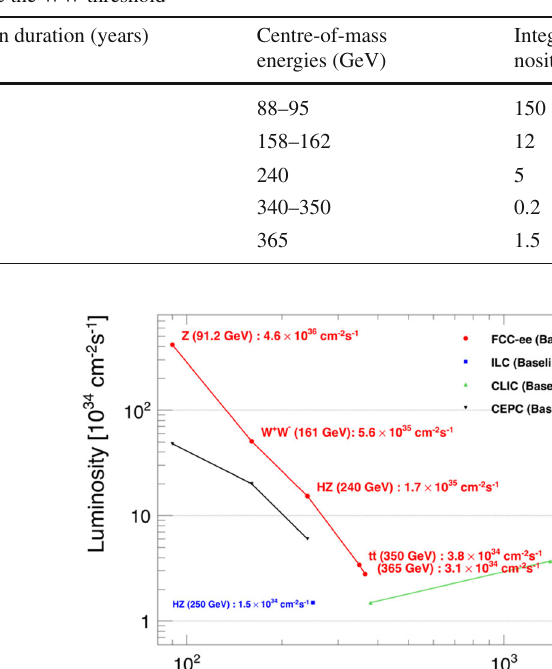
Table 2.1 Run plan for FCC-ee in its baseline configuration with two experiments. The number of WW events is given for the entirety of the FCC-ee running at and above the WW threshold